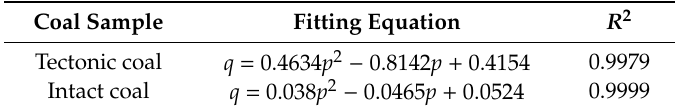
Table 5. Relationship between gas flow rate and gas pressure during gas